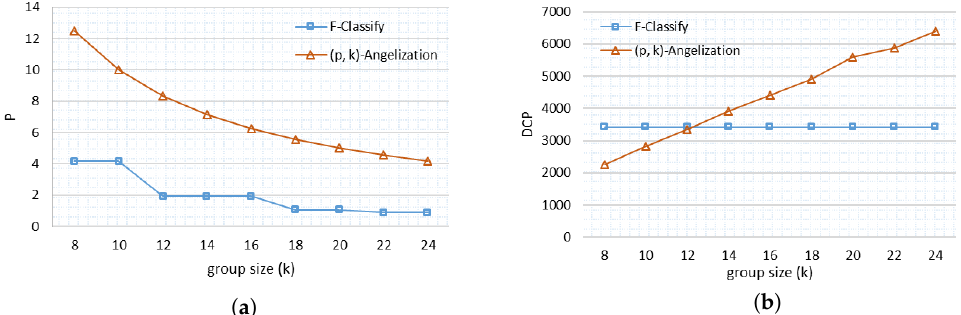
Figure 4. Comparison of Heart Disease Data set ( a ) Probability of re-identifying a record ( b ) Discerni- bility